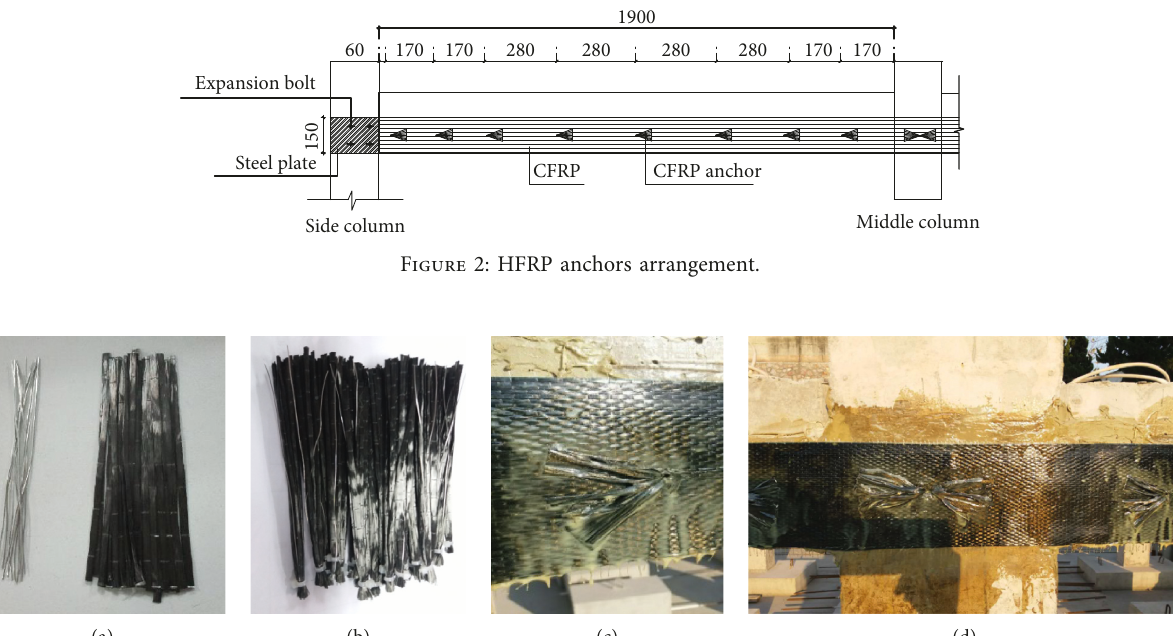
Figure 1: Details of the